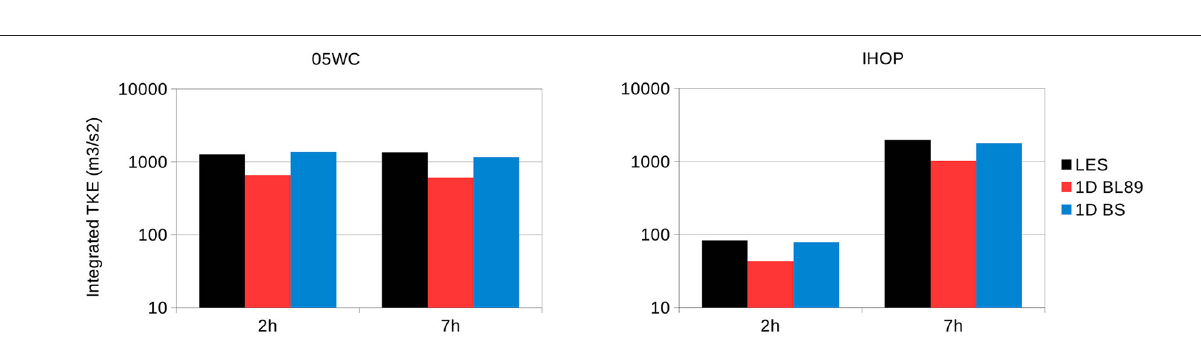
FIGURE 11 | TKE profiles for the convective cases with strong shear 05WC (Left) and weak shear IHOP (Right) ; see Table 1 . Three runs are compared: the LES (black), the SCM with the BL89 length (red), and the SCM with the BS length (blue). Profiles are plotted 2 (dashed line) and 7 h (solid line) after the start of the simulation (dotted line).